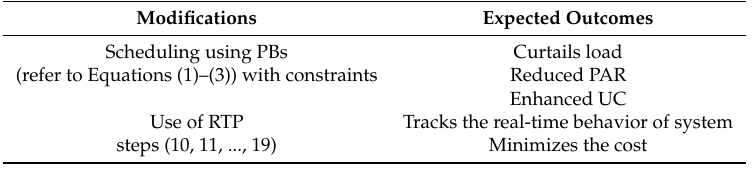
Table 4. Modifications in GA.